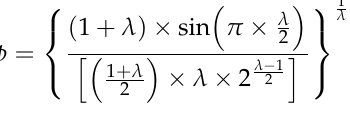
Figure 4. Scheme of fault diagnosis based on transient process measuring data.